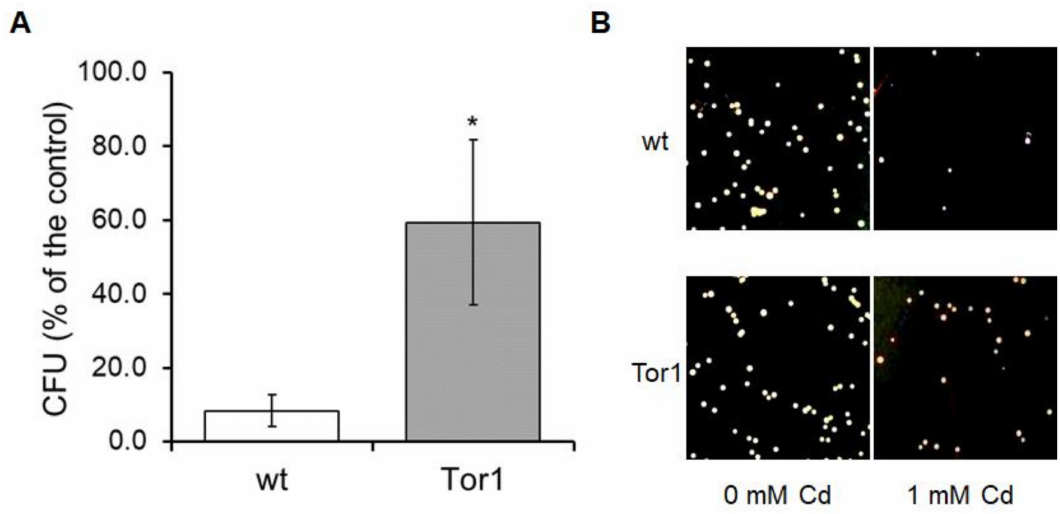
Figure 3. Colony formation of wild-type (wt) and Tor1-null (Tor1) cell lines in the presence of Cd. ( A ) Acute Cd contamination represented by cell exposure to high Cd concentrations (1 mM) for 3